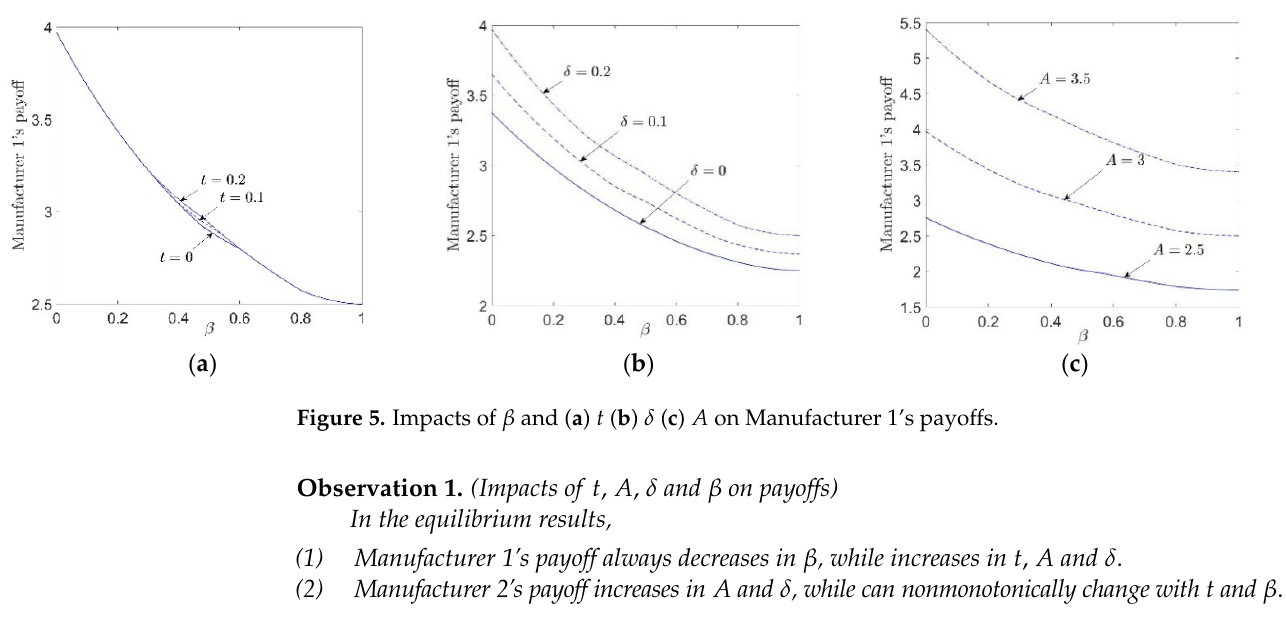
. ( a ) ; ( b ) ; ( c ) . 𝑡𝑡 = 0.2 𝛿𝛿 = 0 𝛿𝛿 = 0.1 𝛿𝛿 = 0.2 A